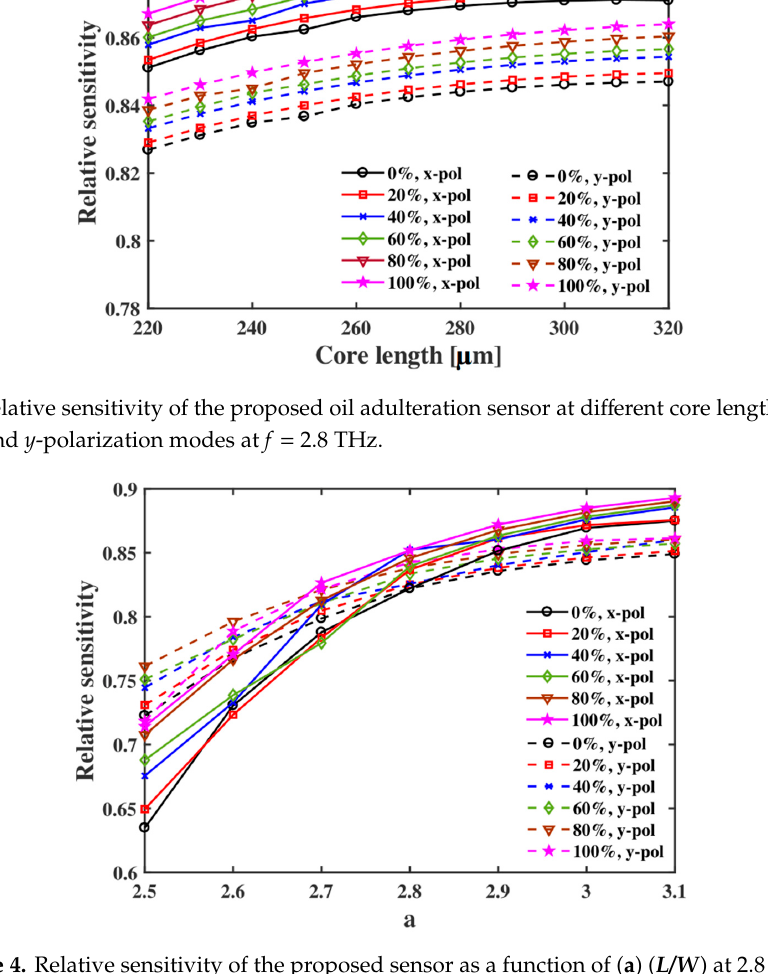
Figure 5. Relative sensitivity of this oil adulteration sensor at different air filling fraction at 2.8 THz and L = 280 µm.